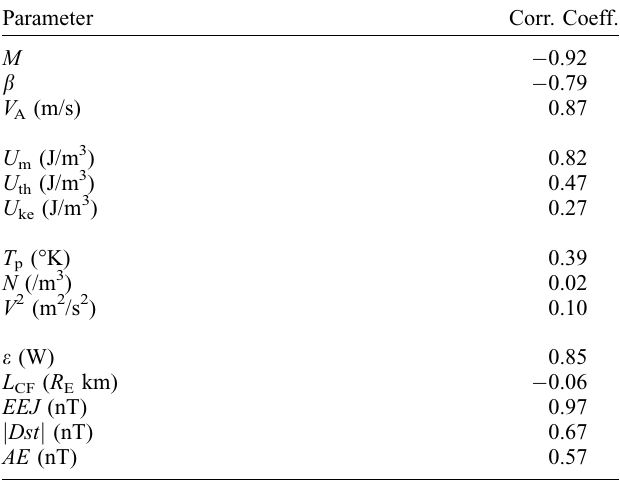
Fig. 4. The time variation of monthly smooth solar wind (a) magnetic energy density ( U m ¼ B 2 = 2 l ( U ke ¼ Nm p V 2 = 2), (c) thermal energy density ( U th ¼ NK B ð T p þ T e Þ = 2) at Earth’s bow-shock nose. The errors in the monthly smooth values of corresponding parameters are shown by gray color. Vertical black dashed lines indicate the start of SC 22, 23 and 24. Table 3. Correlation coefficients between monthly SSN and monthly smooth magnetosonic Mach number, SWP beta, Alfven speed, energy densities at Earth’s bow-shock (magnetic, thermal, and kinetic), solar wind parameters (temperature, density, and velocity), e , L CF , and strength of different current systems ( EEJ , | Dst |, AE ,) are given below. We used data for SCs 22, 23, and 24 to get these correlations. Parameter Corr.